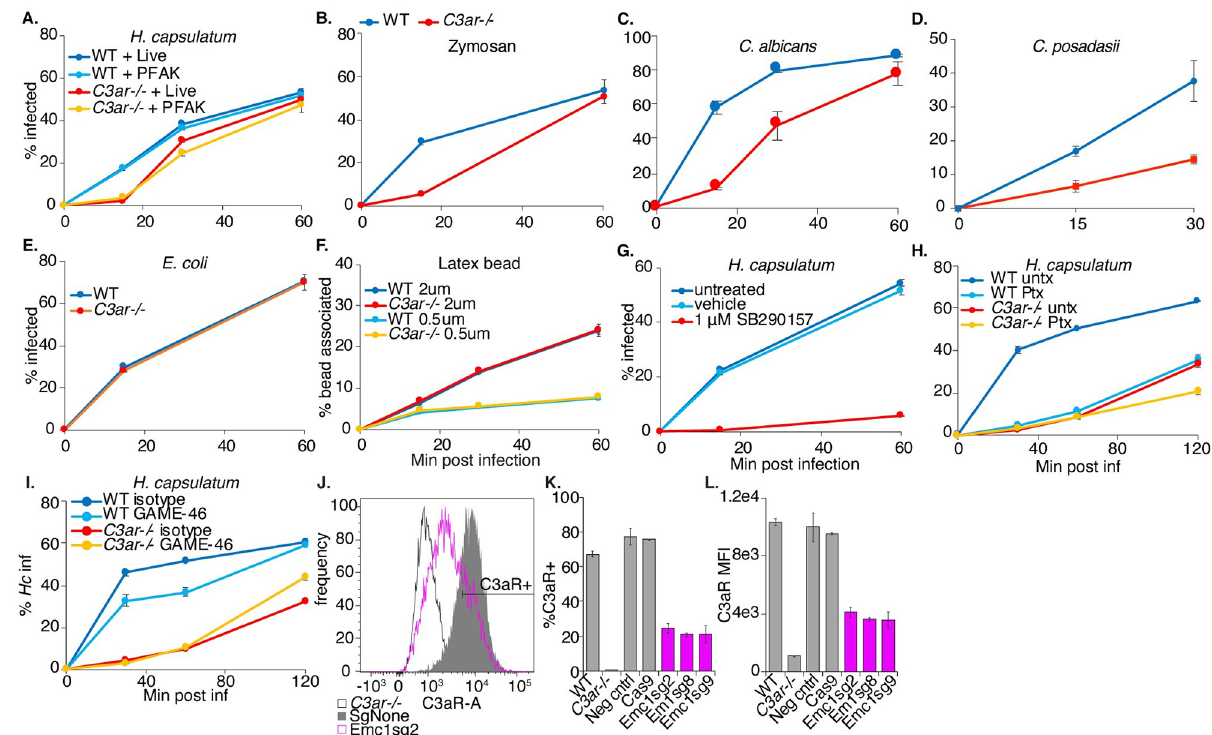
Fig 3. C3aR signaling plays a role in macrophage phagocytosis of fungi. A. WT and C3ar-/- BMDMs were infected with live and PFA-killed mCherry-expressing Hc yeast (MOI2), and the phagocytosis rate was monitored over-time using flow-cytometry (n = 3 biological replicates). B. WT and C3ar-/- BMDMs were infected with FITC-labelled zymosan or mCherry-expressing Hc (MOI2) and the phagocytosis rate infected cells was monitored using flow cytometry (n = 3 biological replicates). C. BMDMs were infected with Candida albicans ( Ca ) (MOI3). Cells were imaged using confocal microscopy to quantify phagocytosis (n = 2 biological replicates, > 350 cells/replicate). CFW staining was used to exclude extracellular Ca . D. BMDMs were infected with FITC-labelled Coccidioides posadasii ( Cp ) arthroconidia (MOI1), and extracellular conidia were labelled with calcofluor white. BMDM infection rates were determined using confocal microscopy (n = 3 biological replicates, 200–400 cells/rep). E. BMDMs were infected with FITC-labelled E . coli bioparticles (MOI4) and the E . coli -association with BMDMs was monitored via flow cytometry (n = 2 biological replicates). F. BMDMs were infected with 2 μ m or 0.5 μ m red fluorescent latex beads (MOI2), and the rate of BMDM association with the beads was measured using flow cytometry (n = 3 biological replicates). G. BMDMs were treated with a C3aR antagonist (1 μ M SB290157) and infected with Hc yeast (MOI2). Phagocytosis was measured using flow cytometry (n = 3 biological replicates). H. BMDMs were pre-treated for 2 h with 1 μ g/mL pertussis toxin (Ptx), which inhibits G α i, and infected with Hc (MOI5, n = 3 biological replicates). I. BMDMs were pre-treated for 90 min with 10 μ g/mL CD18 blocking antibody (GAME-46) and infected with Hc yeast (MOI5, n = 3 biological replicates) Phagocytosis was measured using flow cytometry. Emc1 is required for C3aR expression in BMDMs (J-L). J. Emc1 CRISPRKO BMDMs and control sgRNA transduced BMDMs, and C3aR levels were measured via flow cytometry following C3aR surface staining (n = 2 biological replicates). K. Histogram of C3aR levels in control and Emc1 CRISPRKO BMDMs. L. Frequency of C3aR+ cells in the indicated BMDMs. M. The mean fluorescence intensity (MFI) of the C3aR signal in the indicated